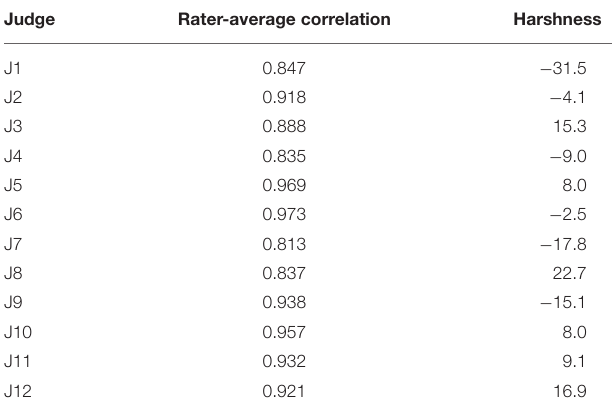
TABLE 2 | Group 1 rater reliability and harshness indicators. TABLE 3 | Group 2 rater reliability and harshness